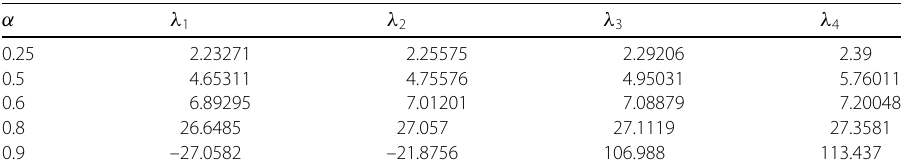
Table 1 Numerical approximations to the first four eigenvalues of problem (24)–(25) according to (cid:12) 750 E δ , θ ( z ) = k =0